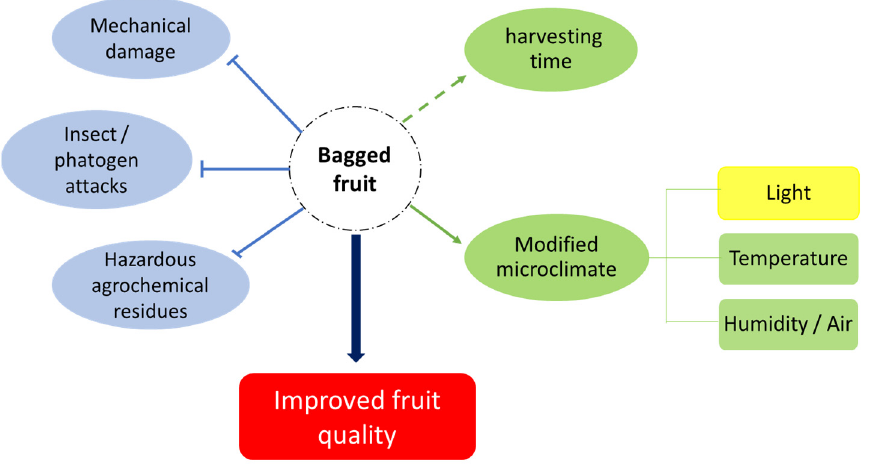
Figure 3. A model showing the influence of bagging on the quality of fruits. In particular, this technique seems to be able to find wide areas of application in the markets where the sale of organic products is developed, both in relation to the reduction of chemical inputs and the greater economic sustainability of this approach in a more profitable supply chain. In this regard, it is also hoped for the development of research aimed at the economic evaluation of these techniques, an area that is still almost com- pletely unexplored but which, thanks to the availability of advanced analysis approaches (e.g., life cycle assessment analysis), could provide useful information to support the entire production chain.